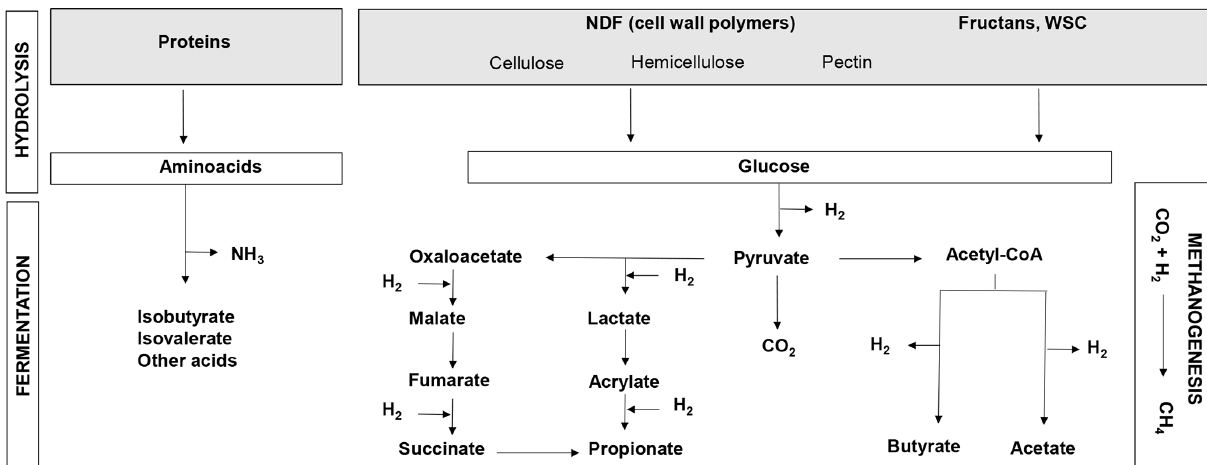
Figure 1. Overview of protein and carbohydrate metabolism in the rumen. WSCs: water-soluble carbohydrates; NDF: neutral detergent fiber (cell wall carbohydrates); CH 4 : methane; CO 2 : carbon dioxide; NH 3 : ammonia; H 2 :